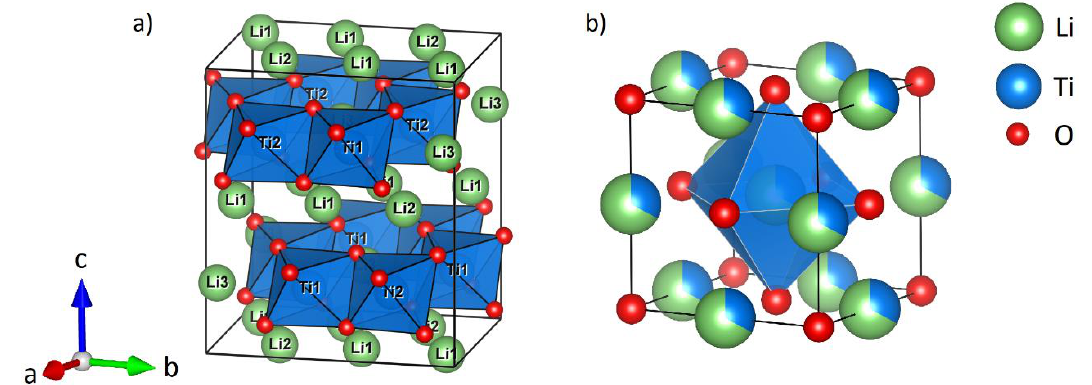
Figure 1. Unit cell of monoclinic β -Li 2 TiO 3 ( a ) and cubic α / γ -Li 2 TiO 3 ( b ). The green spheres represent lithium, blue titanium and red oxygen. Only polyhedra around titanium ( a ) or a single octahedra ( b ) are shown, to emphasize the structural features.